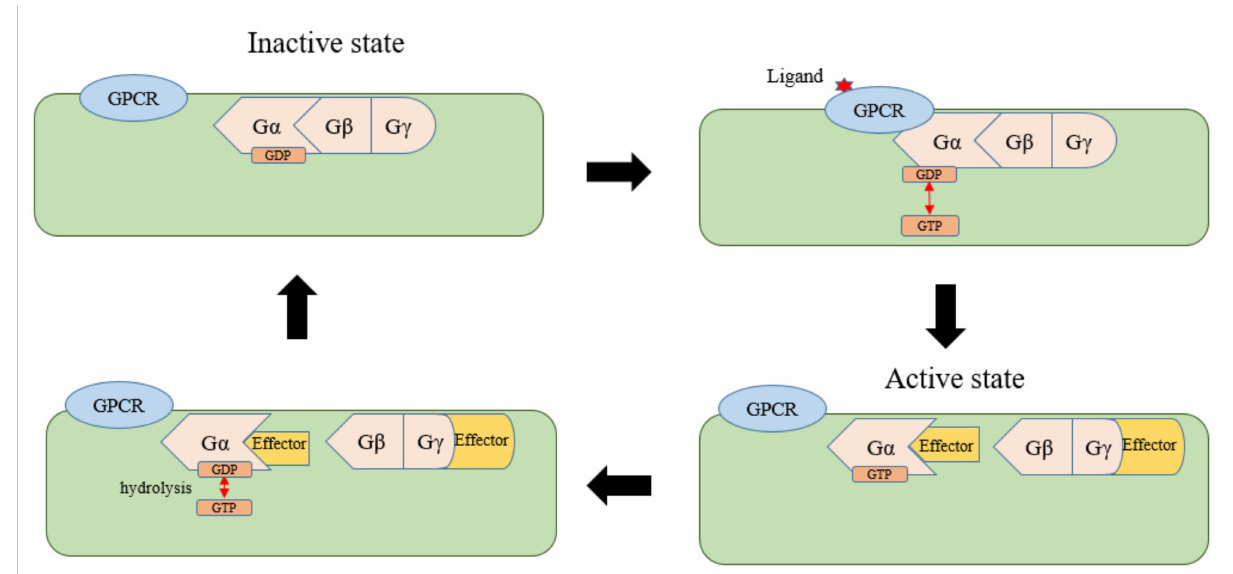
Figure 1. G-protein signaling cycle in